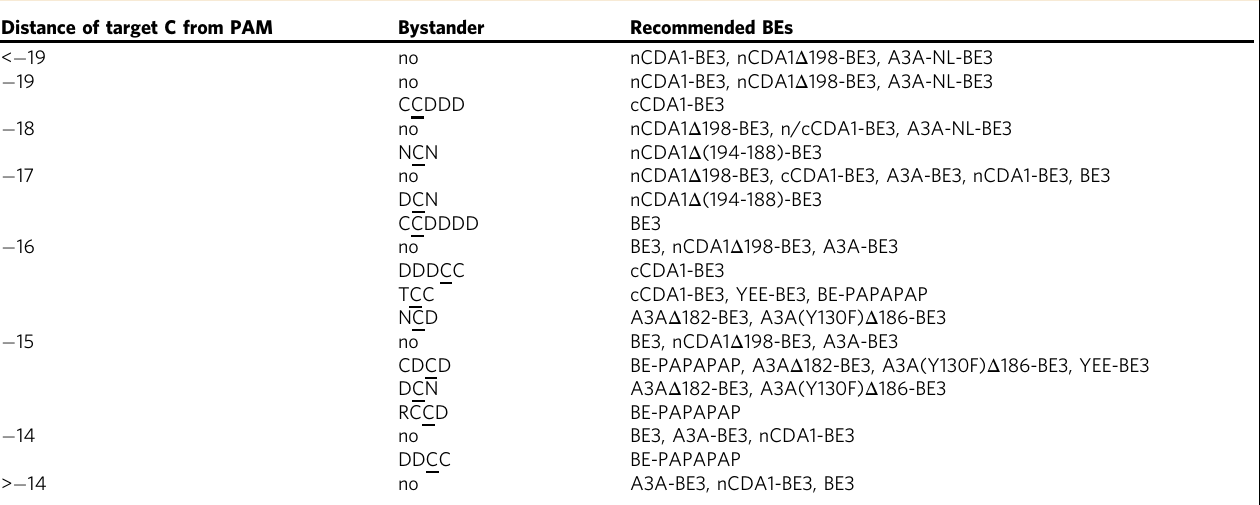
Table 1 Recommendations for BE selection for precision cytosine base editing. Distance of target C from PAM